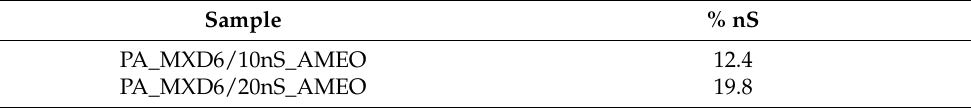
Table 3. Percentage of nanosepiolite present in the masterbatches.